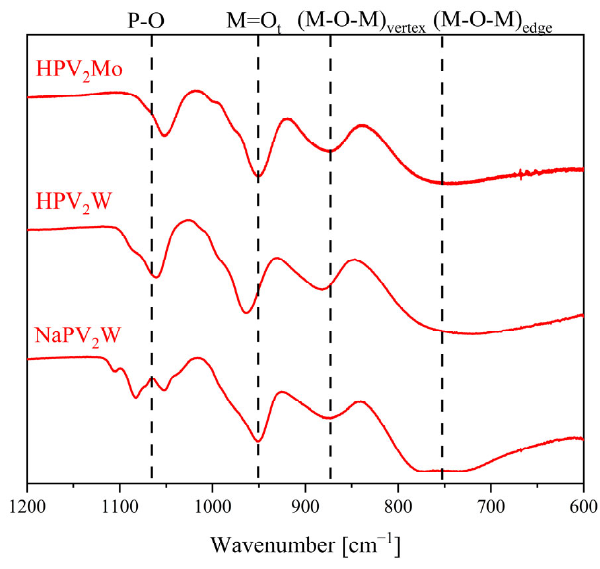
Figure 2. ATR ‐ FT ‐ IR spectra of the POMs NaPV 2 W, HPV 2 W, and HPV 2